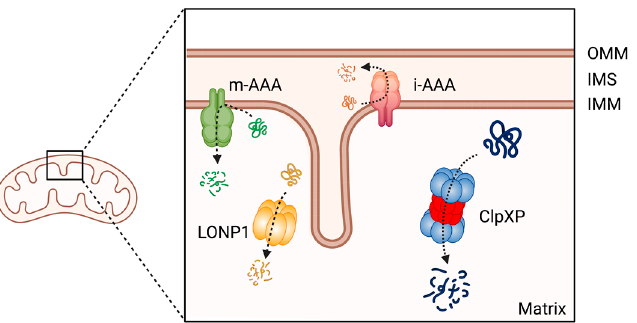
Figure 3. The member of AAA+ protease family in human mitochondria. ClpXP and LONP1 are located in the mitochondrial matrix, the i-AAA and m-AAA are located in the inner mitochondrial membrane. OMM: Outer mitochondrial membrane; IMS: intermembrane space; IMM: inner mitochondrial membrane. This figure was generated by BioRender.com (19 January 2023).